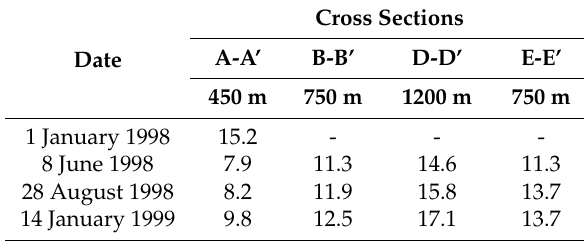
Table 2. Freshwater lens thickness during the 1998–1999 time period on Laura Island, Majuro Atoll for four different cross sections. See Figure 2B for the location of the monitoring